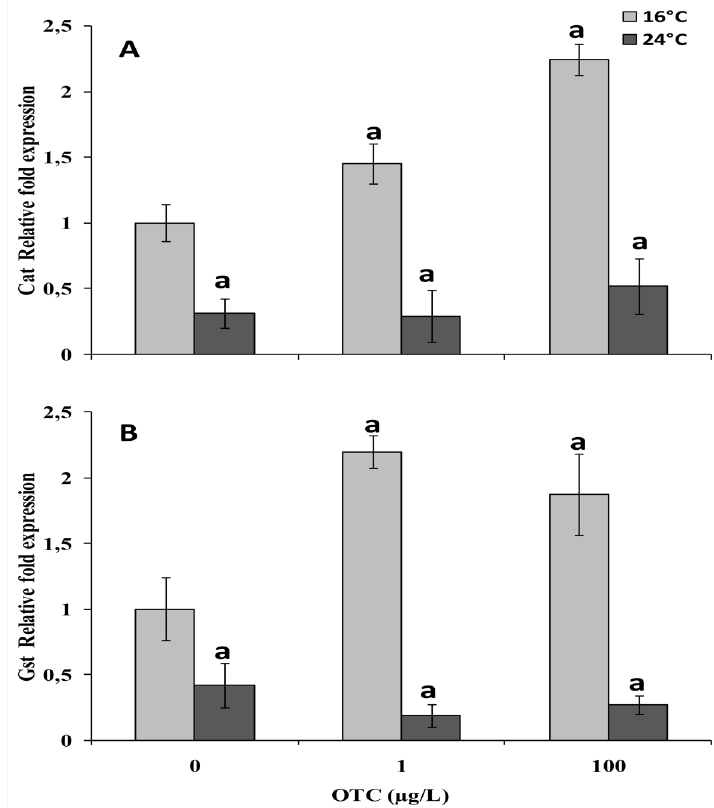
Fig 4. Expression of cat (A) and gst (B) mRNAs in gills of mussels after a 4-day treatment with 1 or 100 μ g/L oxytetracycline at 16° and 24°C. Values are expressed as the mean ± SEM (n = 5) of the relative variations (fold change) between each treatment and the reference condition. Data are expressed asnmole/ mg proteins and represent the mean ± Sd (n = 4). a: significantly different from reference condition. b: significantly different from OTC-untreated mussels at 24°C (p <